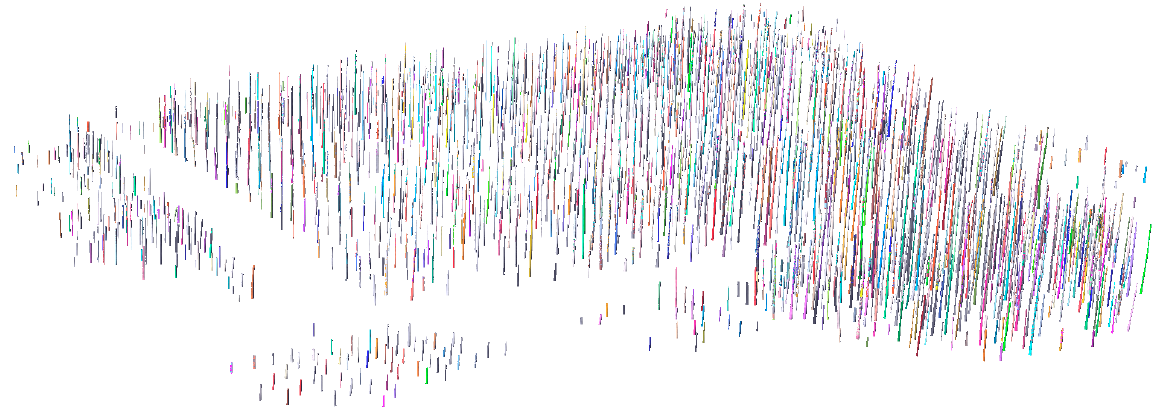
Figure 16. Stems extracted from the dataset of Site 1. Table 4. The number and data size of section points obtained from Dataset A.